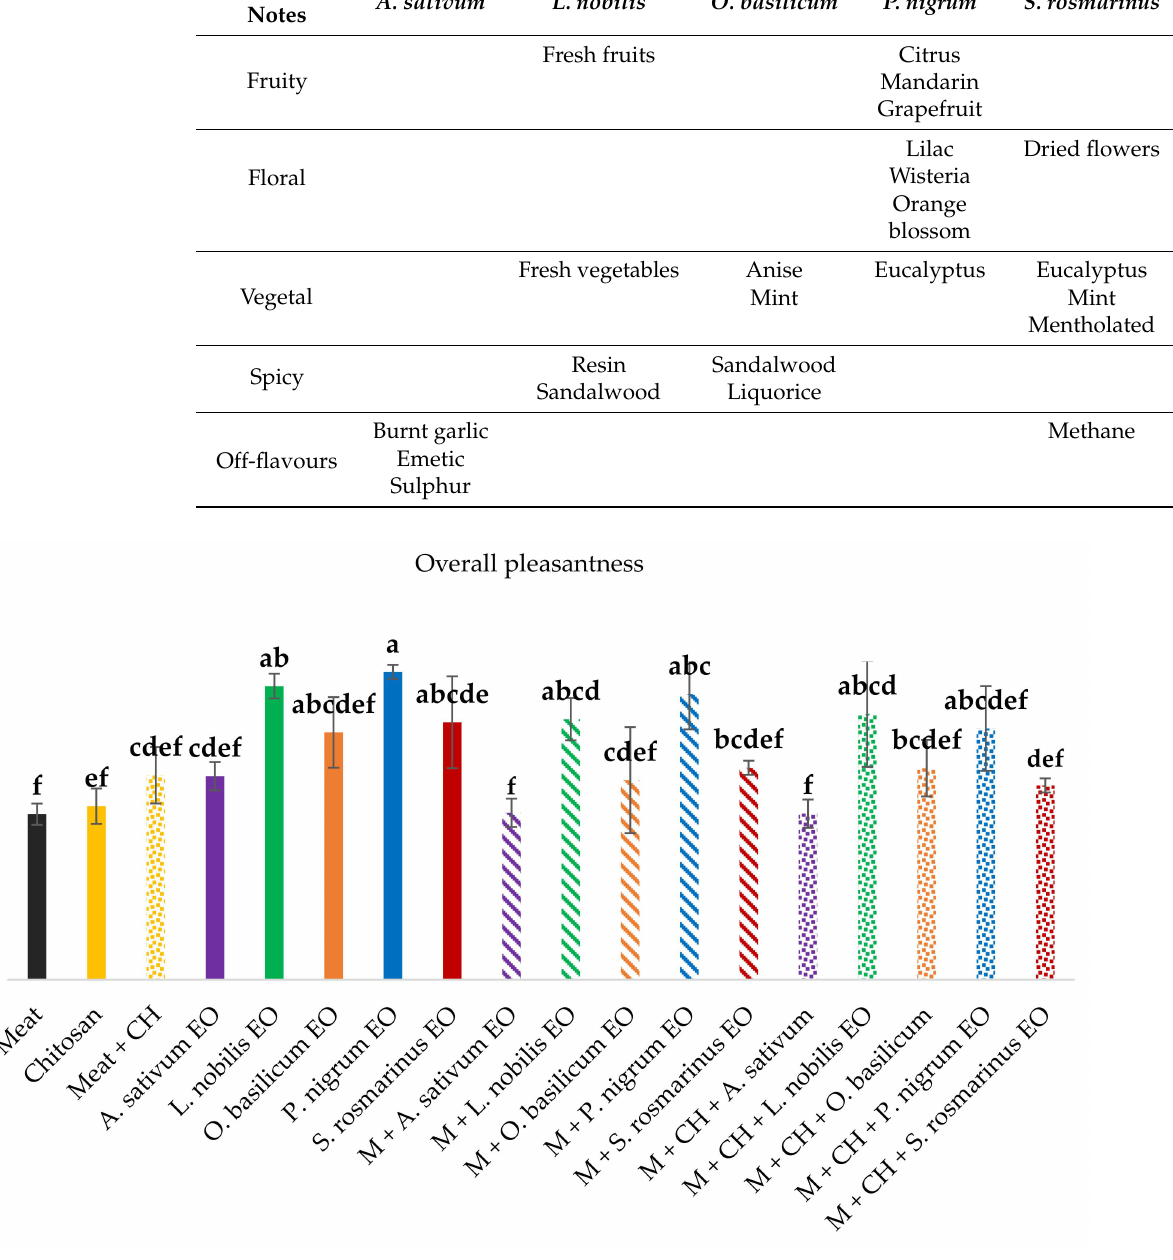
Figure 5. Overall pleasantness of all the samples evaluated by the trained panel on a 0–9 scale. Meat (M); chitosan (CH); Allium sativum , Laurus nobilis , Ocimum basilicum , Piper nigrum , and Salvia rosmarinus essential oil (EO). Different letters (a–f) indicate significant differences. Overall, the presence of CH did not significantly affect the sensorial profile of the meat treated with the EOs. When the meat was treated with the EOs or EOs-enriched CH, the best sensorial profiles were obtained with the L. nobilis EOs and P. nigrum , while the worst ones were associated with the A. sativum EO. Furthermore, meat samples treated with the O. basilicum and S. rosmarinus EOs were close to the limit of acceptability, regardless of the presence of